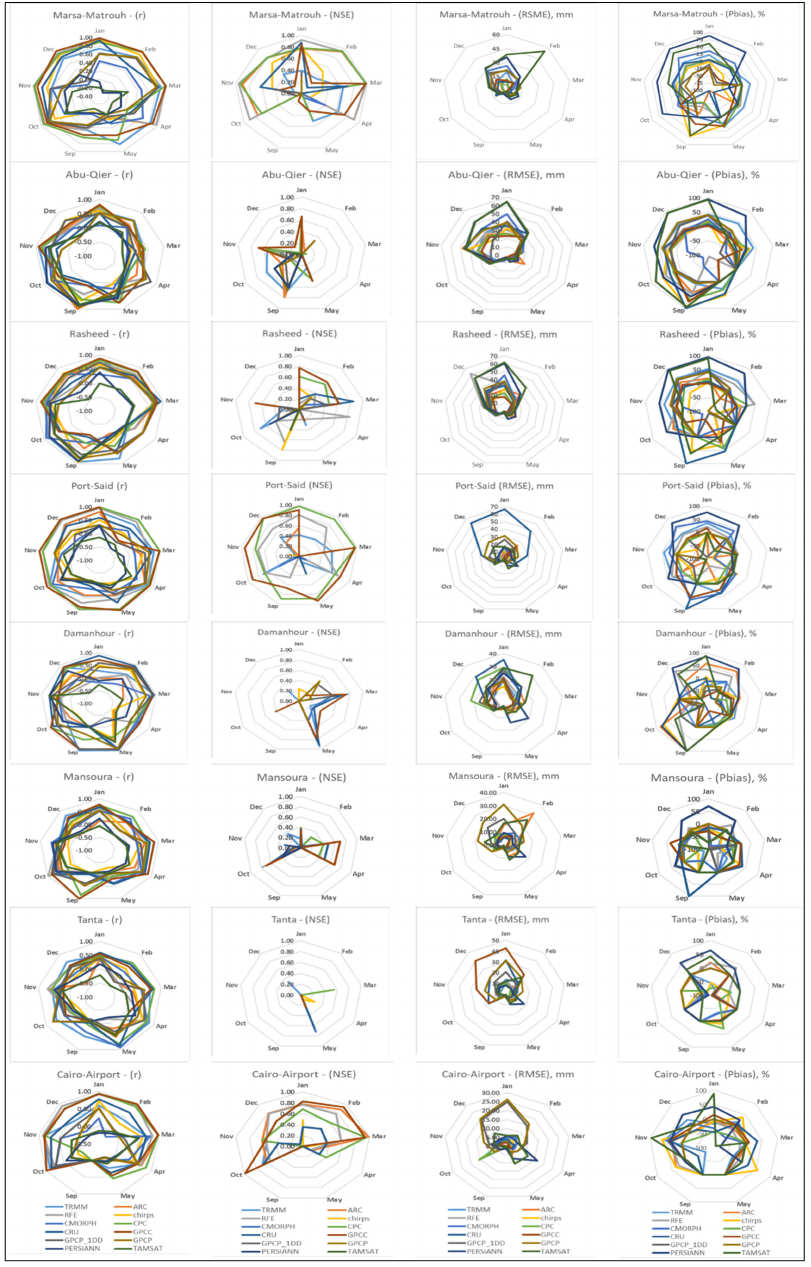
Figure 5. Monthly statistical evaluation results for each RP at the studied